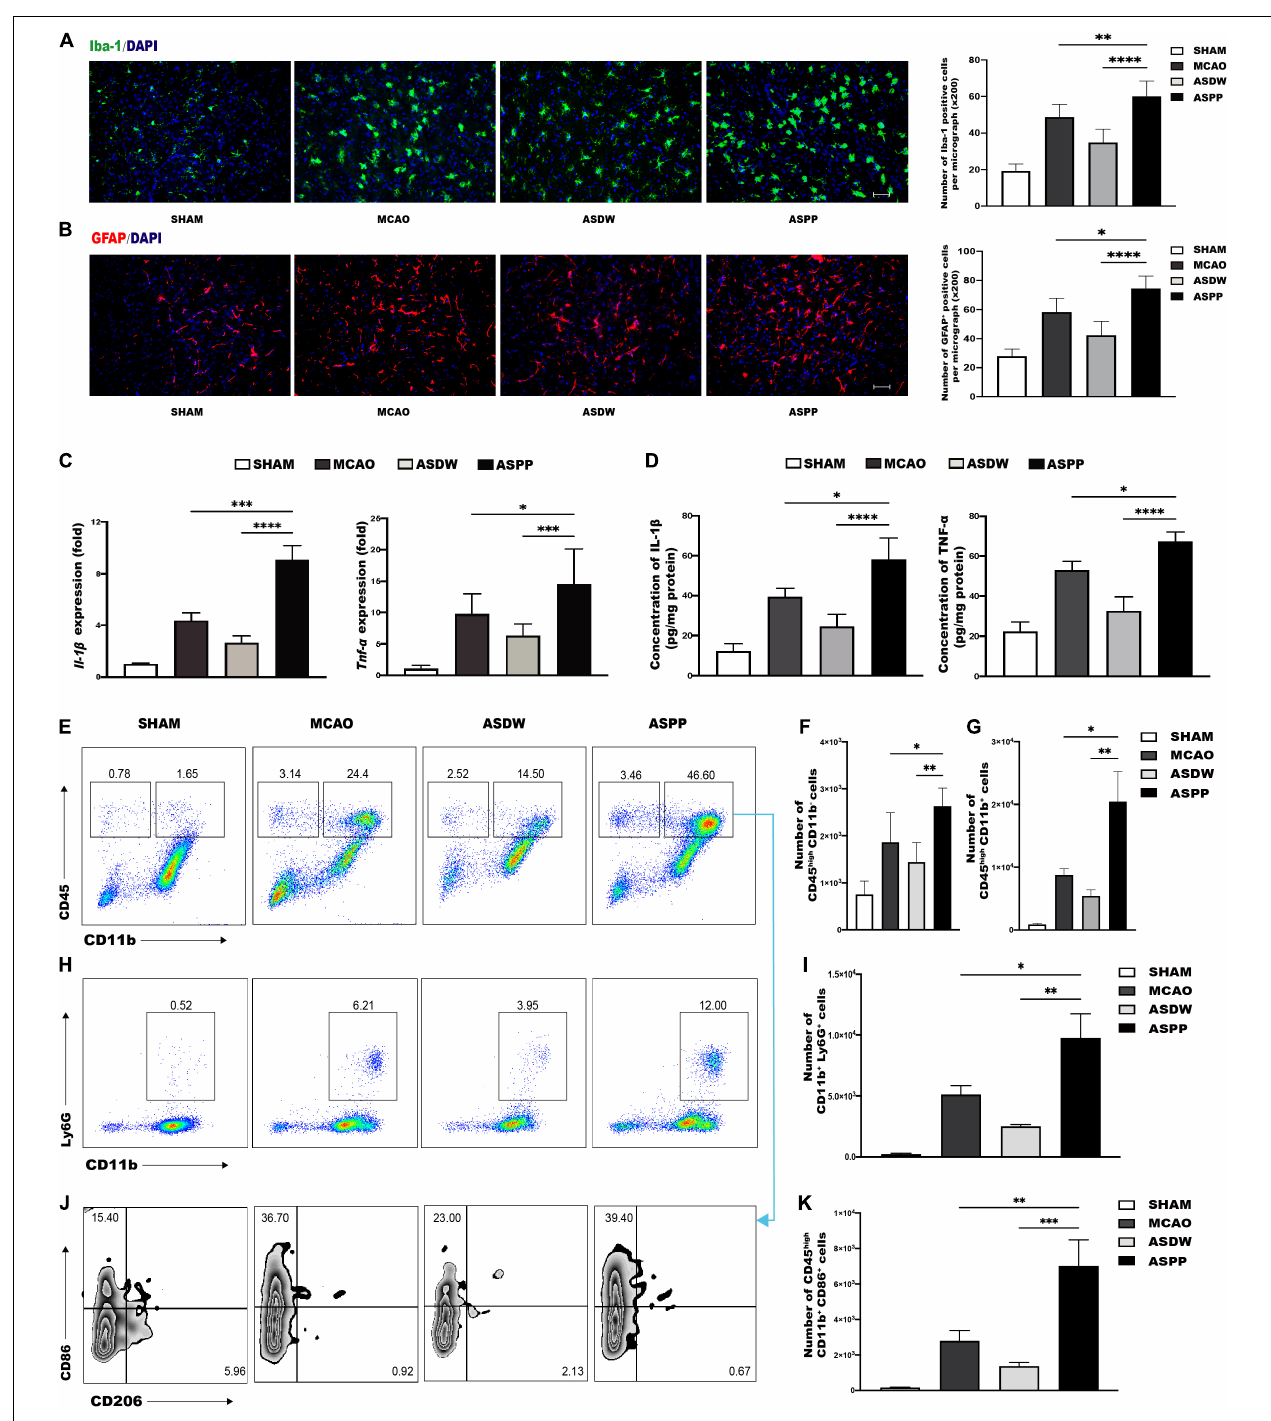
FIGURE 2 | Gavage of periodontitis salivary microbiota promotes inflammation in the ischemic region. (A) Left, representative immunofluorescence staining of Iba-1 in the ischemic region of the brain. Scale bar = 100 µ m. Right, quantification of Iba-1-positive cells. n = 5:5:5:5. (B) Left, representative immunofluorescence staining of GFAP in the ischemic region of the brain. Scale bar = 100 µ m. Right, quantification of GFAP-positive cells. n = 5:5:5:5. (C) qPCR analysis of relative mRNA expression of Il-1 β and Tnf- α in the ischemic brain. n = 7:12:8:10. (D) IL-1 β and TNF- α detected by ELISA in the ischemic brain. n = 4:4:4:4. (E) Representative flow cytometry analysis of CD45 high CD11b − cells and CD45 high CD11b + cells in ischemic brain. (F) Quantification of CD45 high CD11b − cells. n = 6:6:6:6. (G) Quantification of CD45 high CD11b + cells. n = 6:6:6:6. (H) Representative flow cytometry analysis of CD11b + Ly6G + cells. (I) Quantification of CD11b + Ly6G + cells. n = 5:5:5:5. (J) Representative flow cytometry analysis of CD86 and CD206 in CD45 high CD11b + cells. (K) Quantification of CD45 high CD11b + CD86 + cells. n = 6:6:6:6. Values represent mean ± SD. One-Way ANOVA was used for statistical analysis. ∗ p < 0.05, ∗∗ p < 0.01, ∗∗∗ p < 0.001, ∗∗∗∗ p < 0.0001.